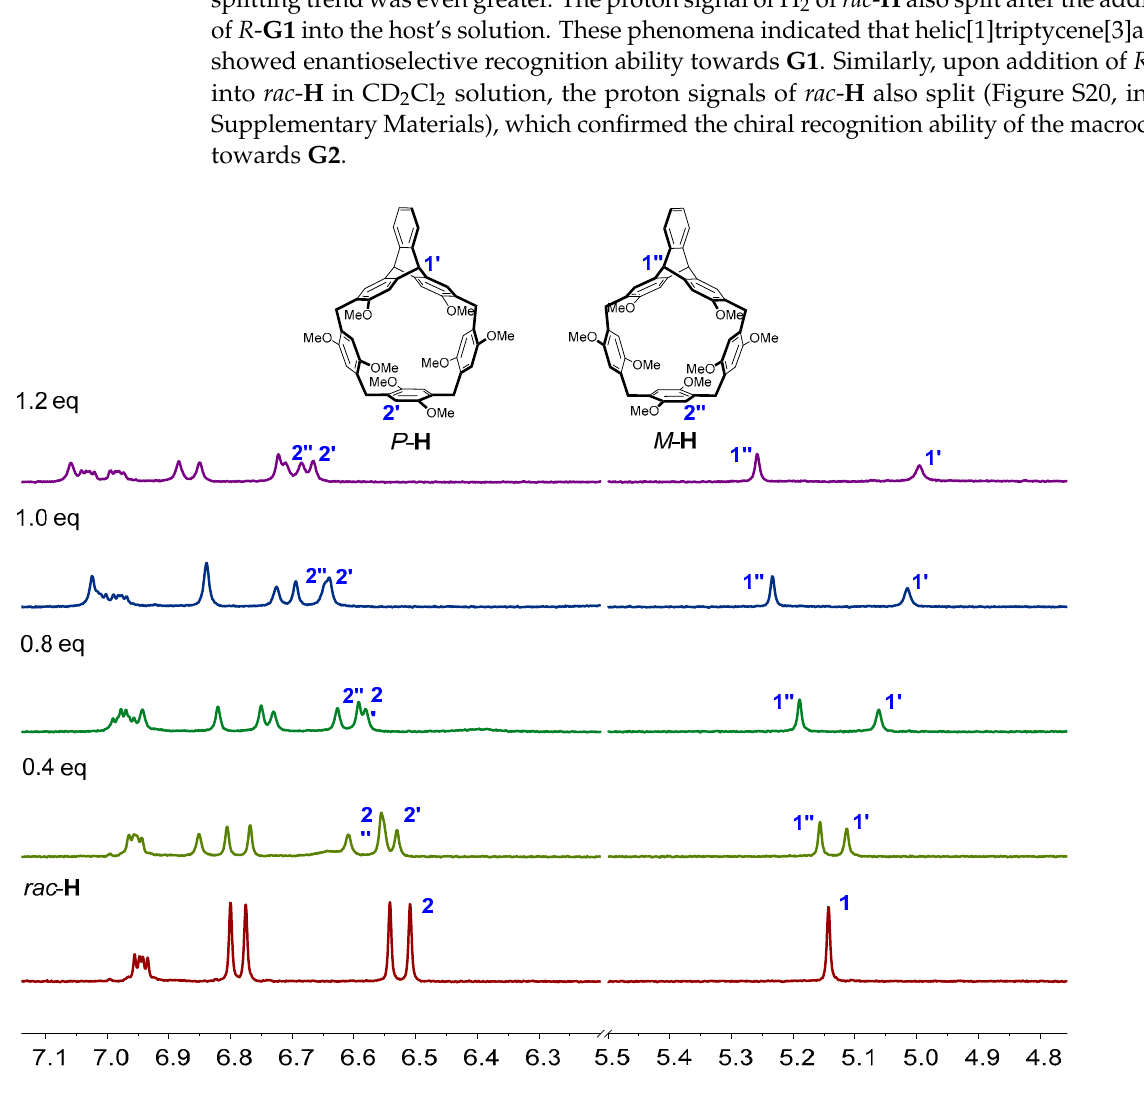
3 ) of 2.0 mM rac - H with different amounts of R - G1